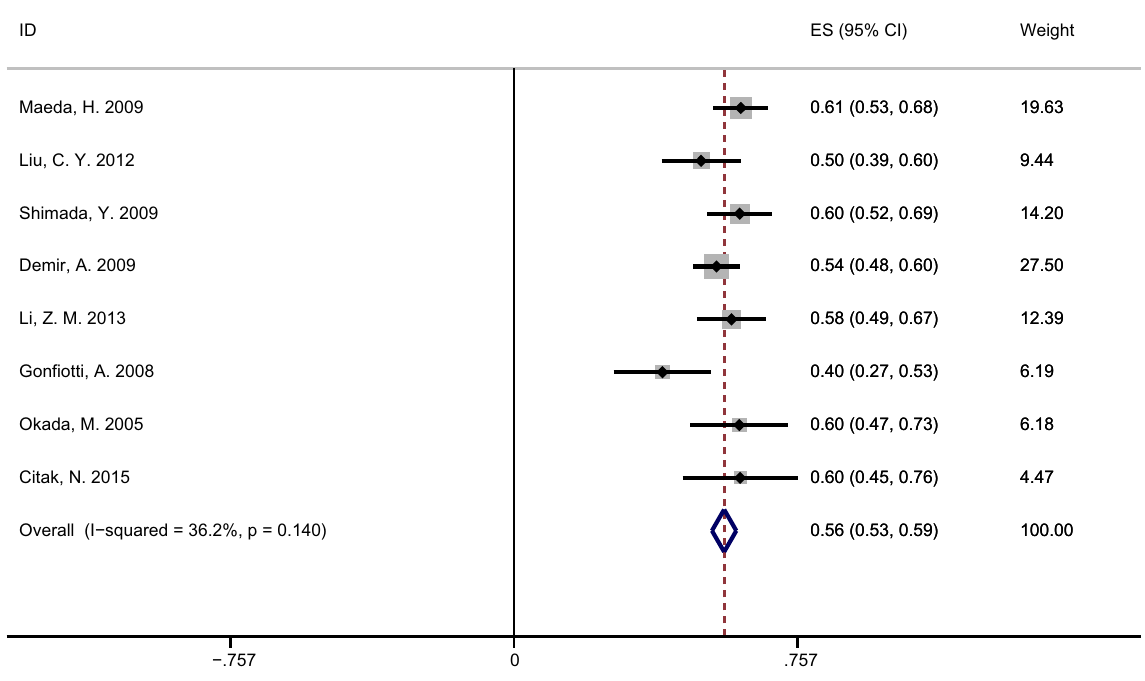
Figure 4. Forest plot of 5-years OS for patients diagnosed with pN1p